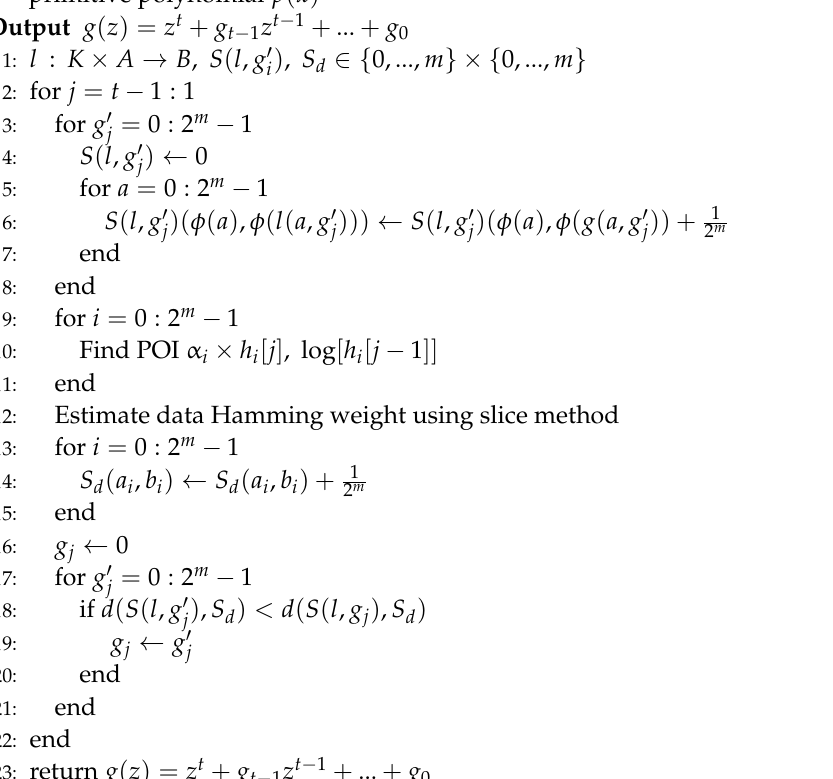
Estimate data Hamming weight using slice